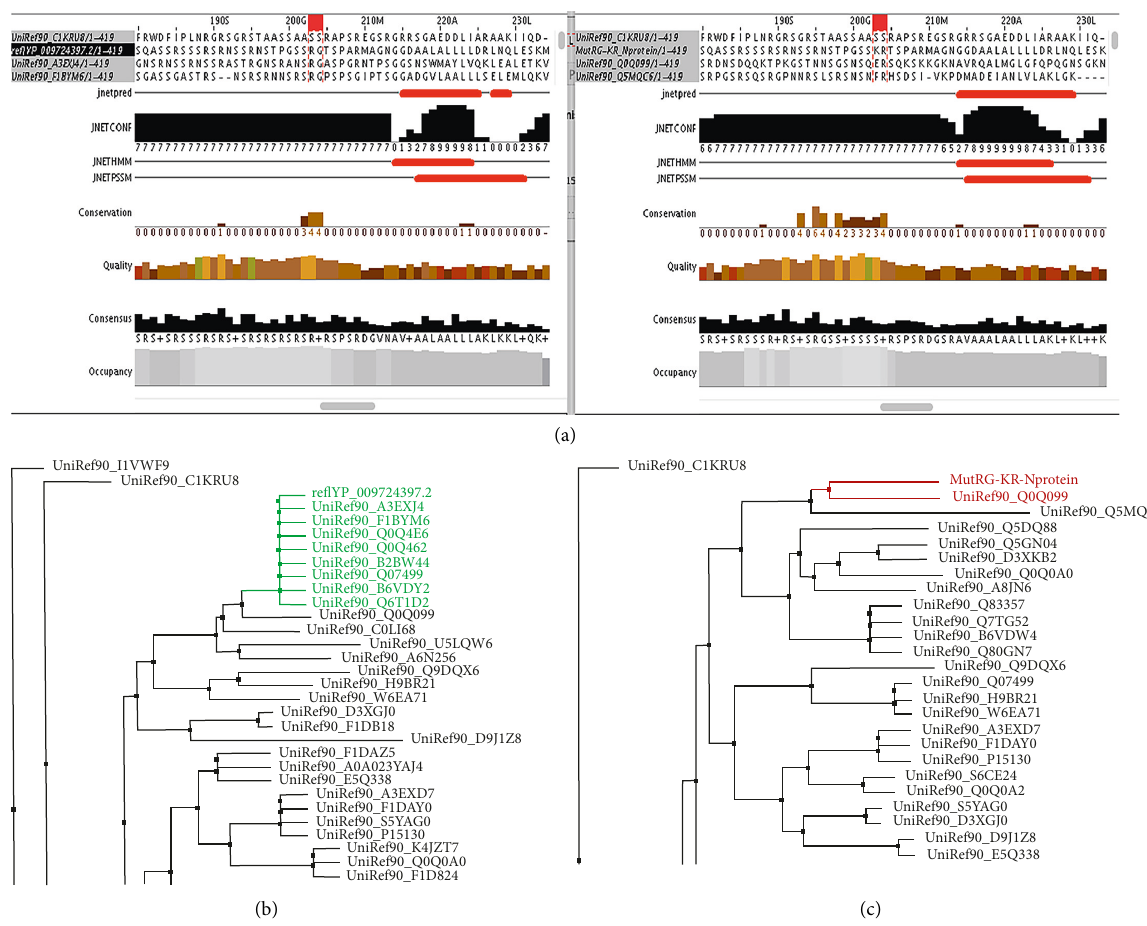
Figure 4: Impact of the RG > KR mutation on N protein structure. (a) The amino acid mutation at 203–204 position of the N protein changes the size and arrangement of the alpha-helix of the protein as indicated by the red bars. The left panel in the image is the reference N protein, whereas the right panel represents the mutated N protein. Conservations, quality, and consensus have been indicated at the bottom layers of the image. (b) Neighbor-joining clustering based on RG dipeptide after multiple sequence alignments shows seven proteins (green) as the neighbor of the wild type N protein. (c) Clustering based on the mutated KR dipeptide has found only one immediate neighbor (red) to the mutated N protein indicating its rarity. In both cases, the distances of the other branches indicate the different types of dipeptides found in other viruses.